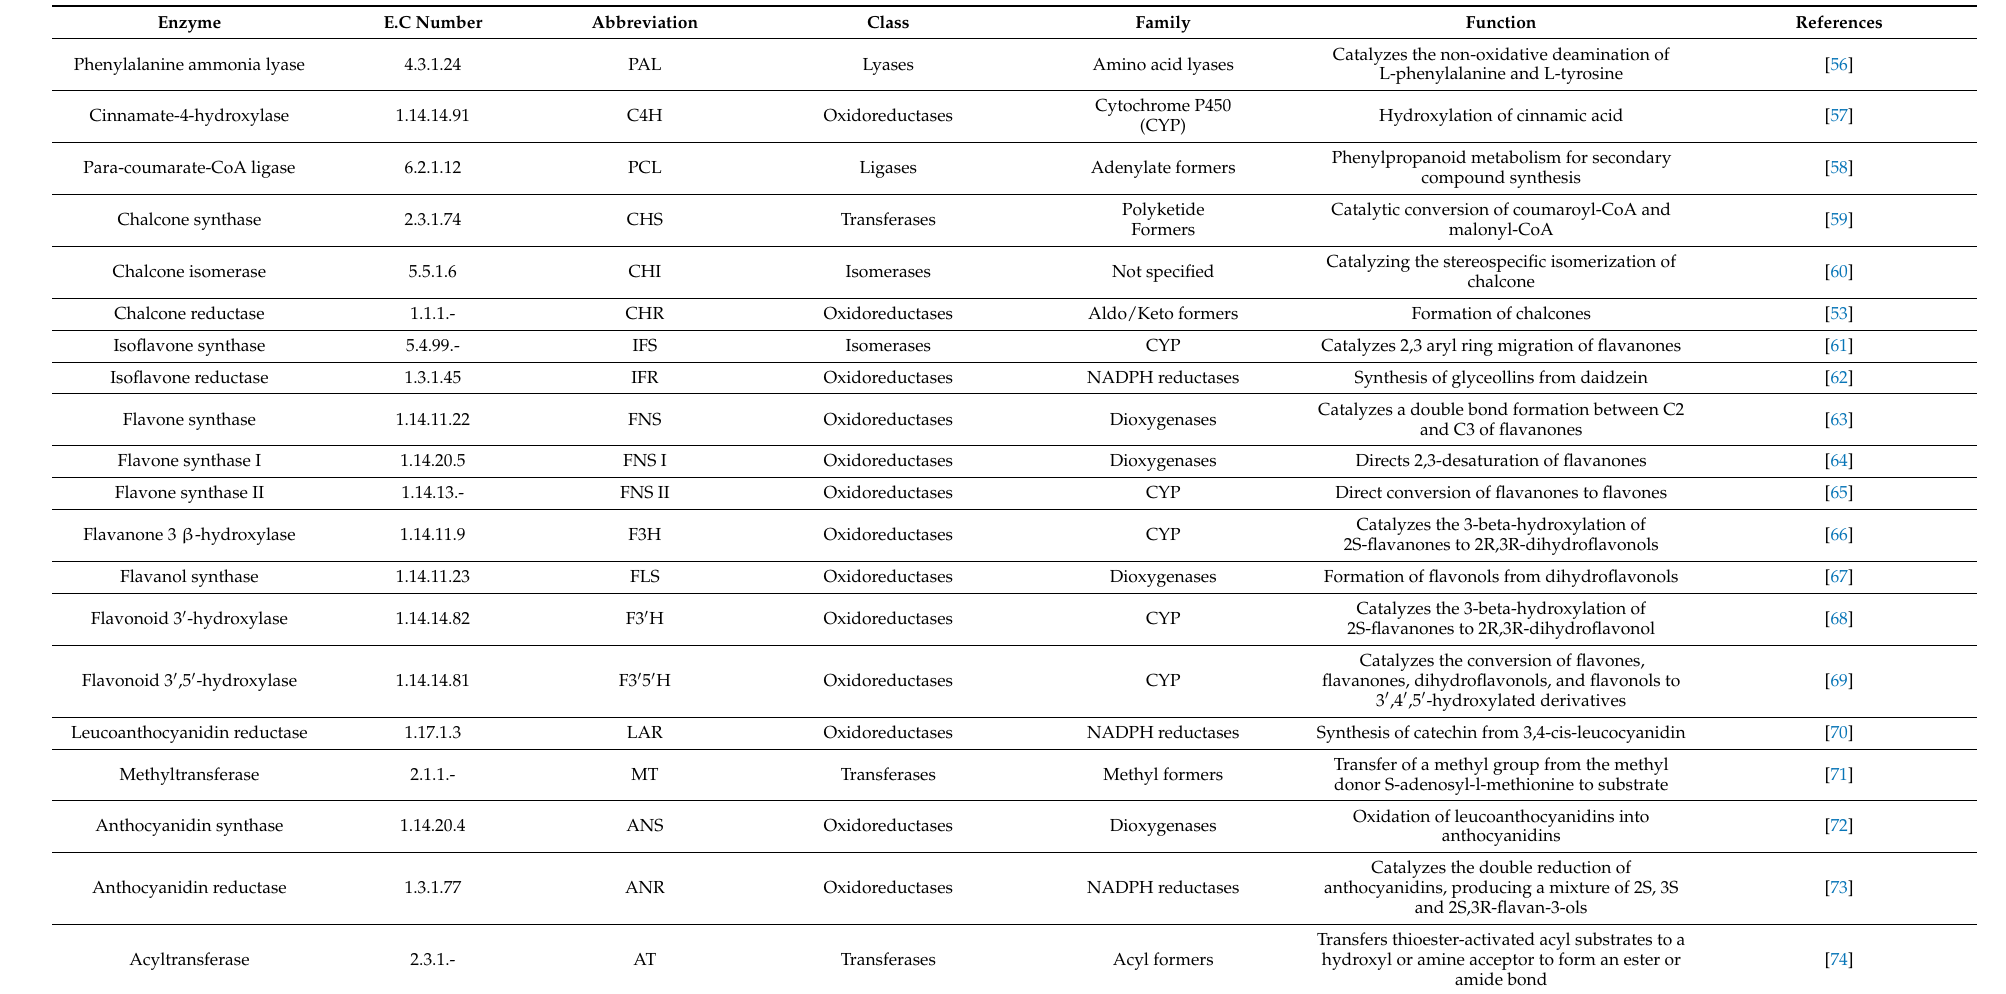
Table 1. Enzymes Associated with Biosynthesis of